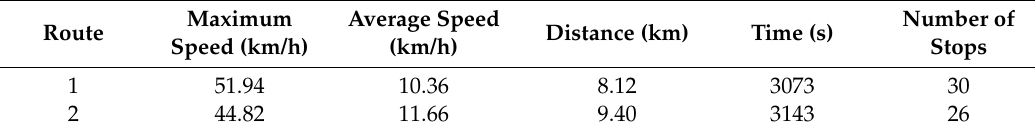
Figure 4. Actual speed and height profiles for a typical result along route 2. Table 4. Specifications of the measured driving cycle.